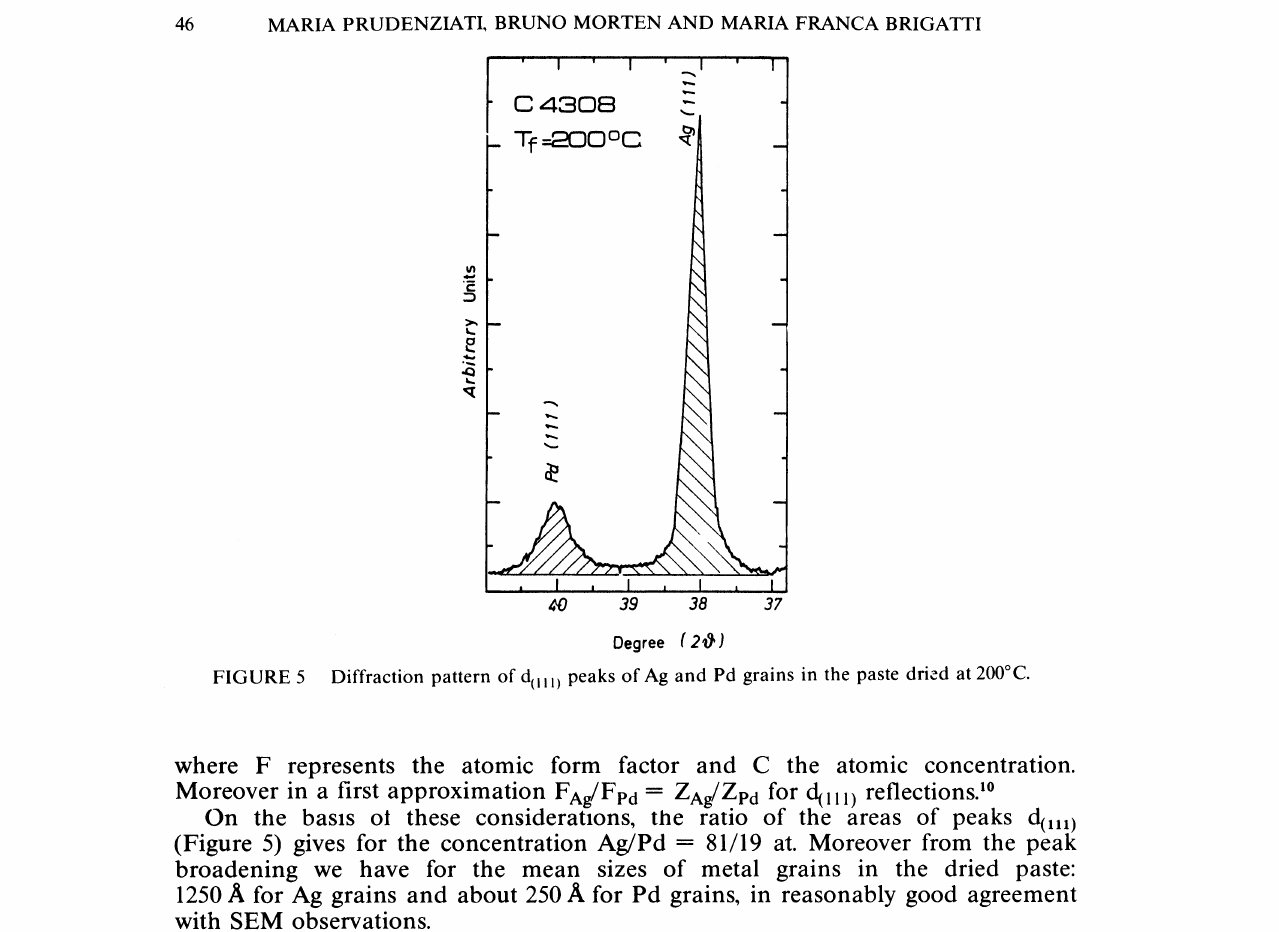
E 4308 Tf =200 oC